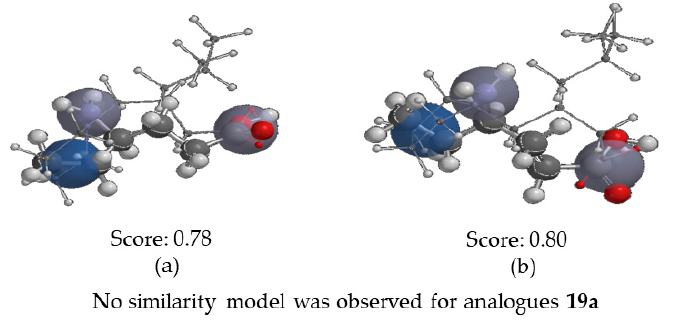
Figure 8. Structure alignment based on the CFD’s of VGB 4 in bioactive conformation with the active analogues. The spheres represent the CFD’s, previously described in Figure 3. ( a ) ( S )- 18a ; ( b ) ( R )- 18a .